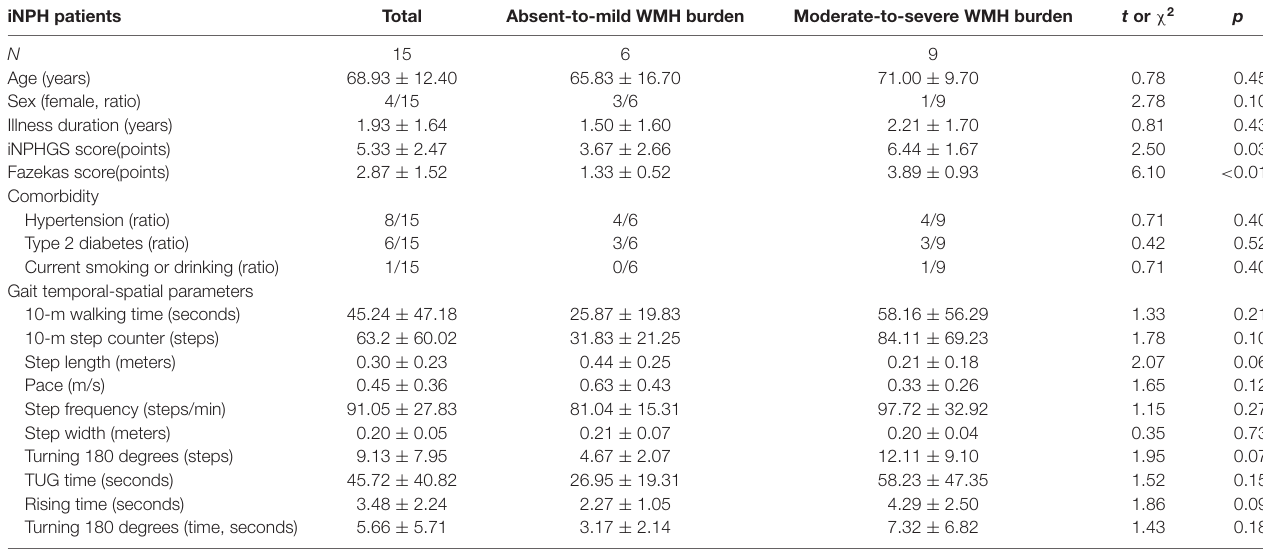
TABLE 1 | Demographic, clinical and gait data of patients. iNPH